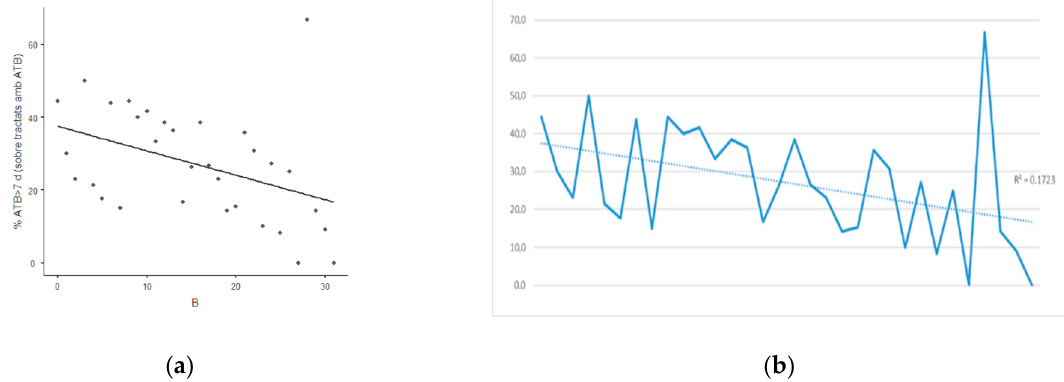
Figure 2. Evolution of the percentage of antibiotic treatments >7 days over patients treated with antibiotics in the Department of Surgery during the first 8 month-period (IP1) ( a) Scatterplot (rho = − 0.492); ( b ) Temporal evolution of the percentage of patients on antibiotic treatment with duration over 7 days (R 2 = 0.172).